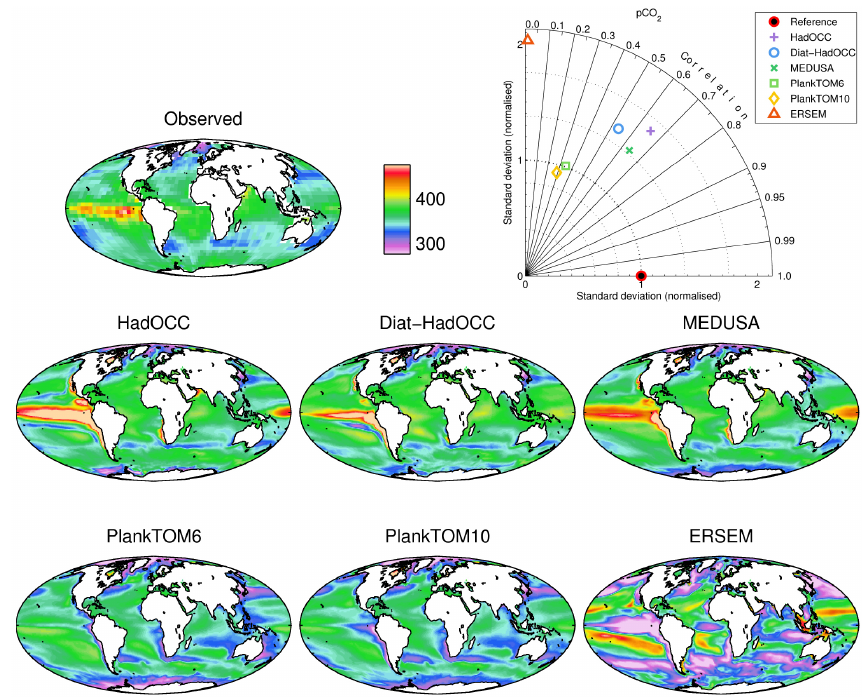
Figure 1. Observational (Takahashi et al., 2009; top left) and modelled annual average surface ocean p CO 2 (µatm) for the year 2000. Mean field values: observations 357.7; HadOCC 368.8; Diat-HadOCC 369.2; MEDUSA 368.5; PlankTOM6 349.8; PlankTOM10 349.5; ERSEM 343.0.